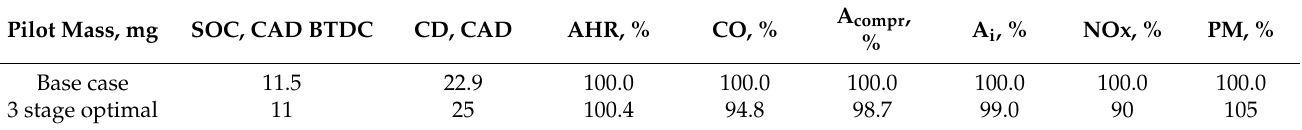
Figure 20. The post SOI variable influence on combustion process and emissions. In Table 5 the combustion parameters are presented. Table 5. Combustion parameters for the optimal injection strategy compared with the base